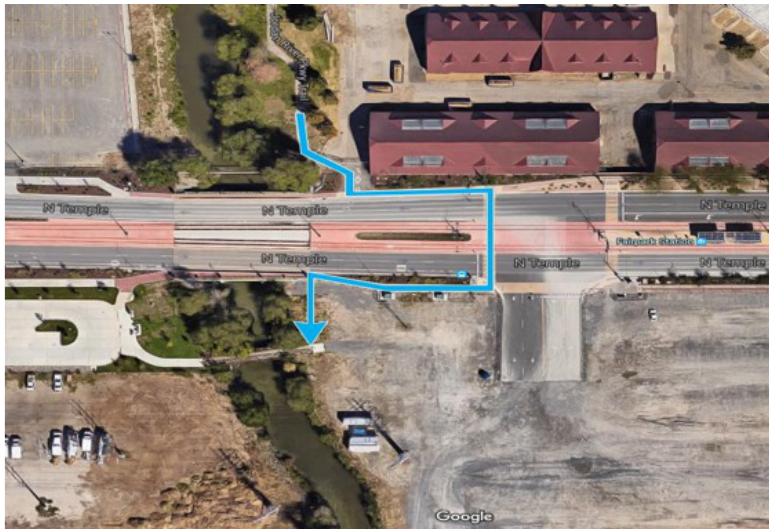
Figure 6. Current pedestrian path for those following the JRPT at its intersection with North Temple. source: created by authors for this paper. source: created by authors for this